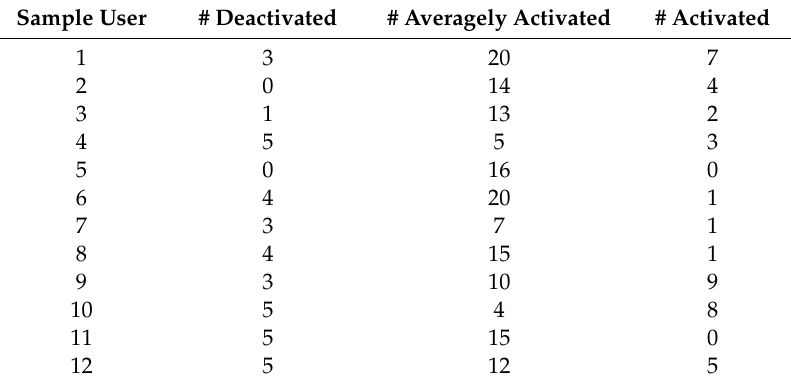
Table 5. Numerousness of the three classes for each sample user. The class with the highest number of elements is underlined. As can be seen, the most populous class was “averagely activated” for most of the